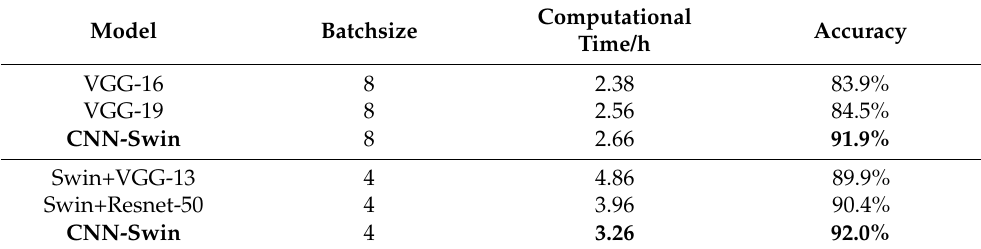
Table 8. Computational complexity analysis of in CNN-Swin